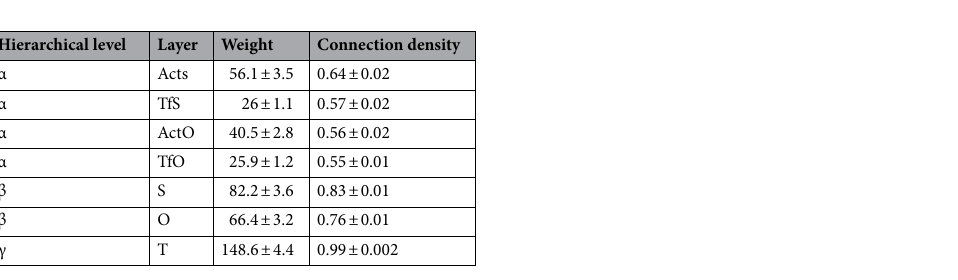
Table 3. Descriptive statistics of layers in a multiplex network. The Interaction Rules refer to the layers in the multiplex network represented in Fig. 8. Weights and Connection density values are given as averages ± S.D.